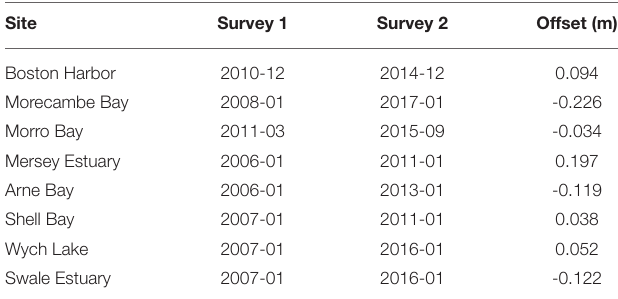
TABLE 2 | Date of surveys and elevation offset for a stable structure between S 2 and S 1. Column 3 shows the offset in elevation between reference structures.